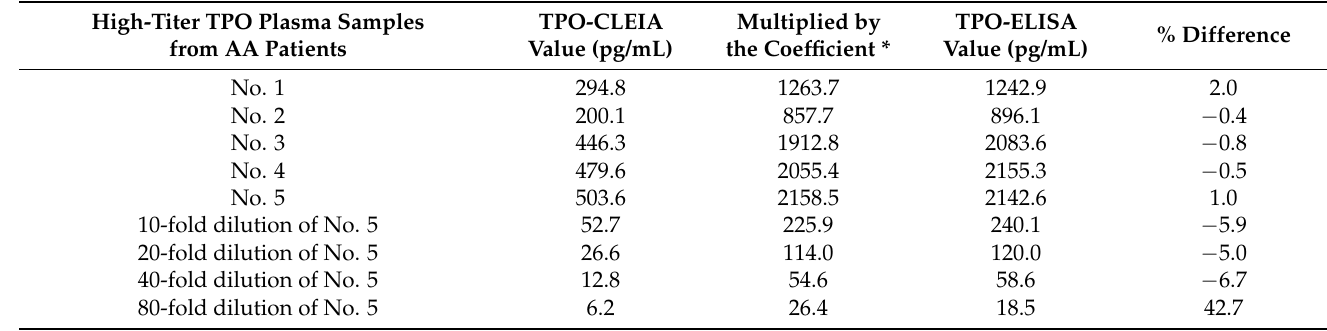
Table 1. Correspondence of measured values in TPO-CLEIA and